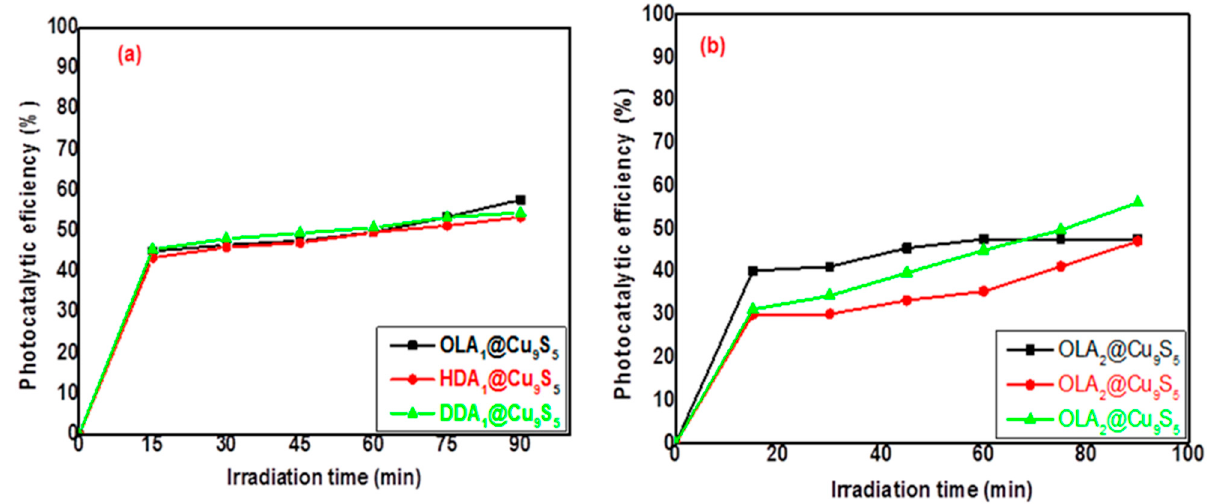
Figure 12. Histograms of degradation efficiencies of MB using copper sulphide nanoparticles at 190 °C versus carbon chain of capping agents using ( a ) complex 1 and ( b ) complex 2.